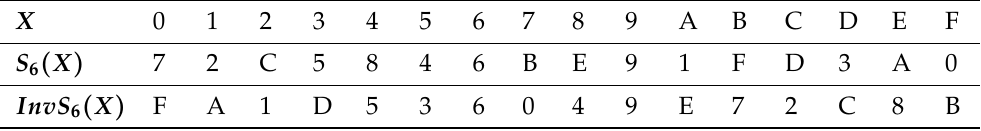
Table 7. Seventh S-Box of Serpent defined as S 6 ( X ) .